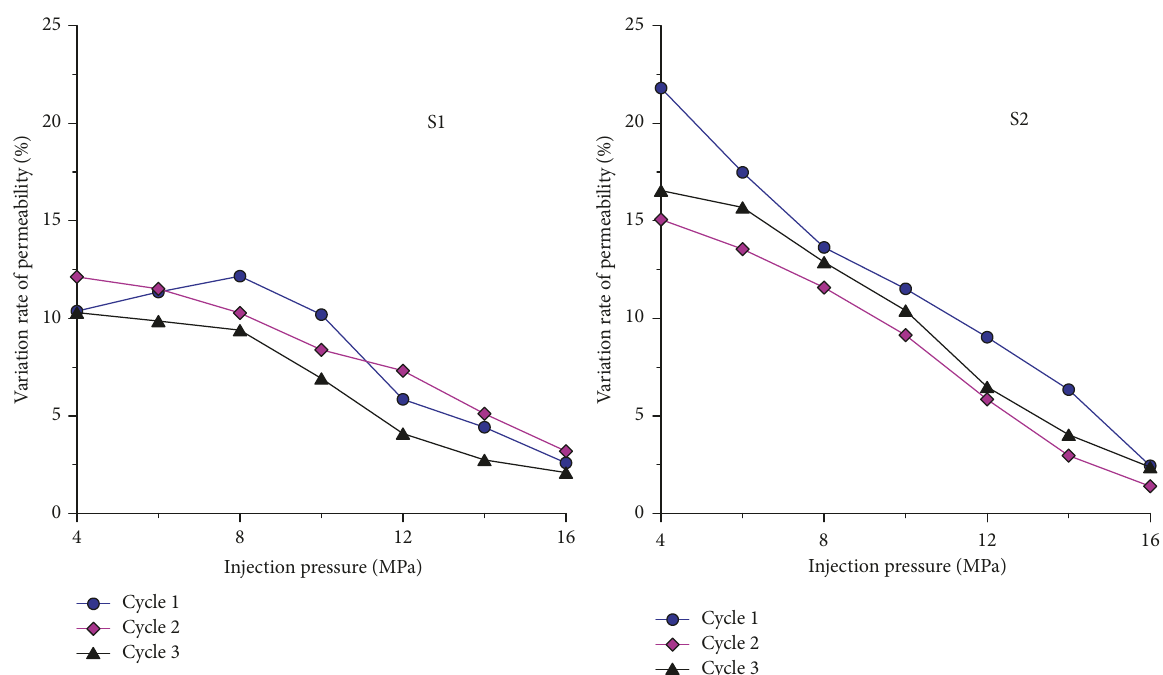
Figure 5: The relationship between the change in permeability and the injection pressure for each cycle experiment.